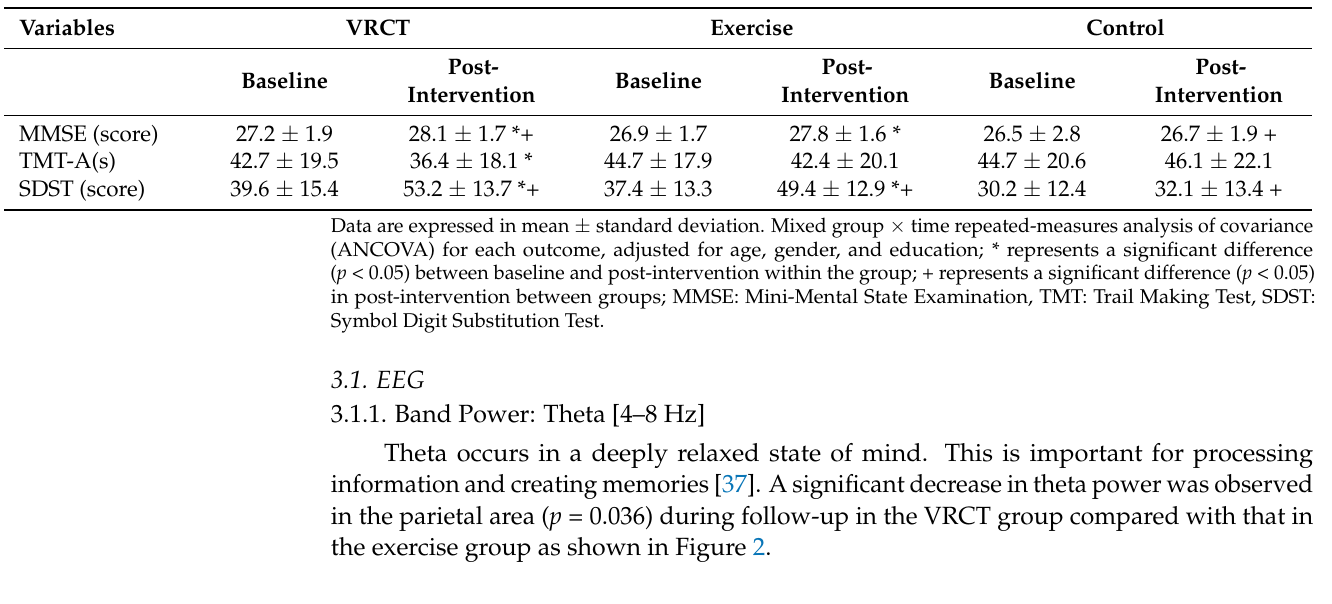
Table 3. The comparison of global cognitive function between baseline and post-intervention the Control, VR and Exercise intervention